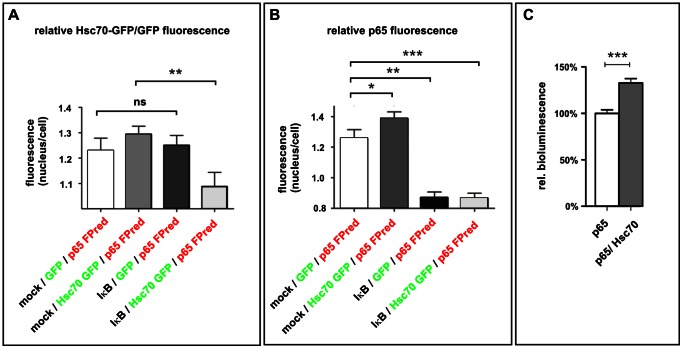
Overexpression of Hsc70 increases nuclear p65 and elevates the activity of NF-κB.
A. HEK293FT cells were transfected with expression vectors as indicated. An inactive state of NF-κB (baseline) was achieved by co-transfection of IκB expression vector. The nuclei and the whole cell body were defined as regions and their mean fluorescence was measured using ImageJ-software. Co-expression of IκB significantly reduces nuclear Hsc70 GFP, whereas no effect on the nuclear localization of GFP was observed. B. HEK293FT cells were transfected as indicated in A. Co-expression with Hsc70 GFP significantly increased nuclear p65-FPred compared to co-expression with GFP. No increase of nuclear FPred p65 was observed if additional IκB was expressed (data not shown). C. Luciferase reporter assay revealed a significant increase of NF-κB activity in HEK293 cells co-transfected with Hsc70 and p65 (+32%), compared to cells over-expressing p65 alone.